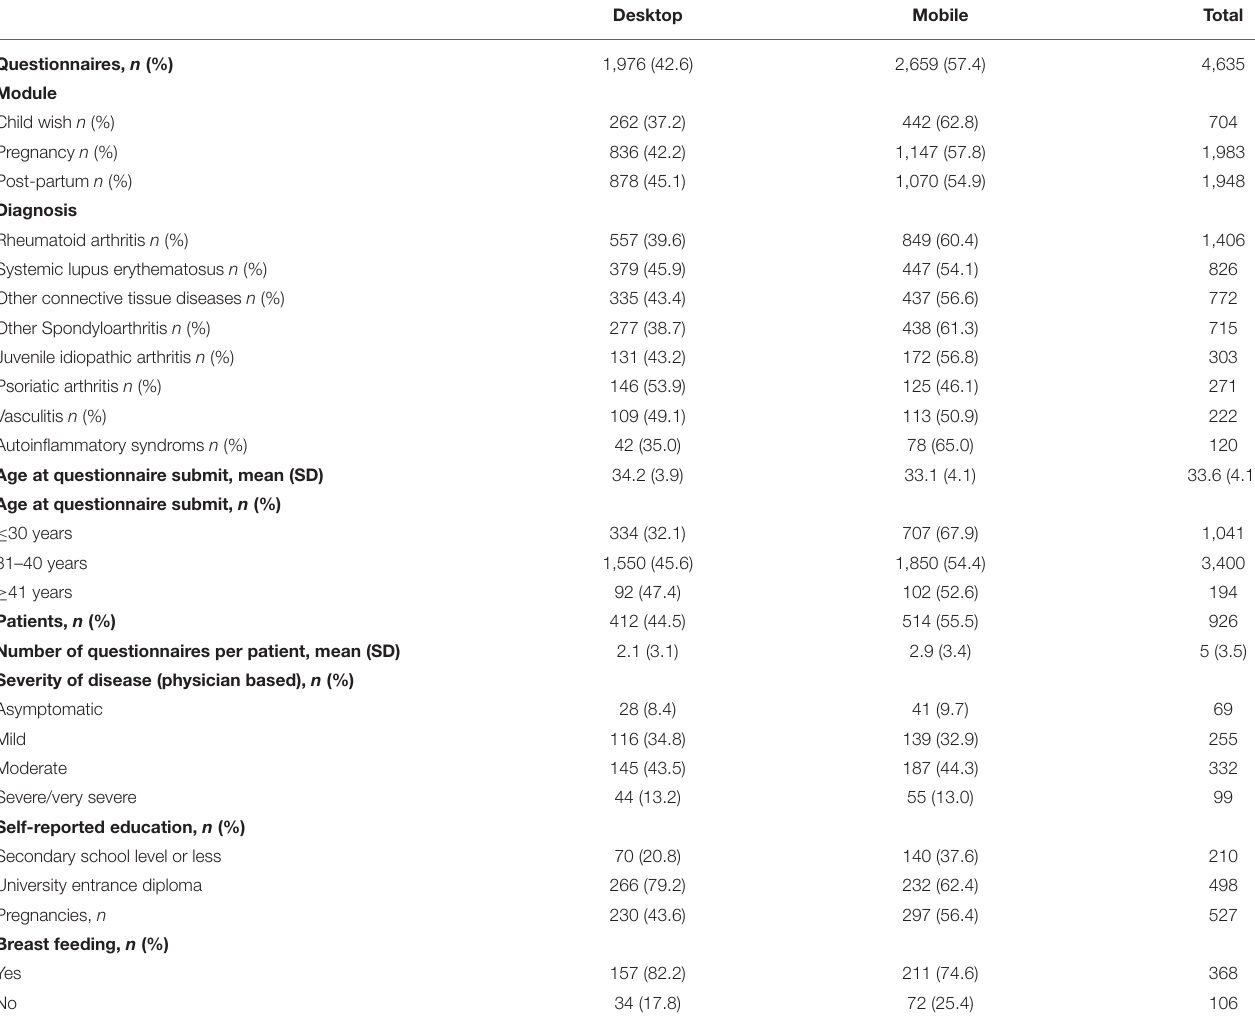
TABLE 1 | Characteristics of patients who filled the forms either via desktop or mobile device. Desktop Mobile